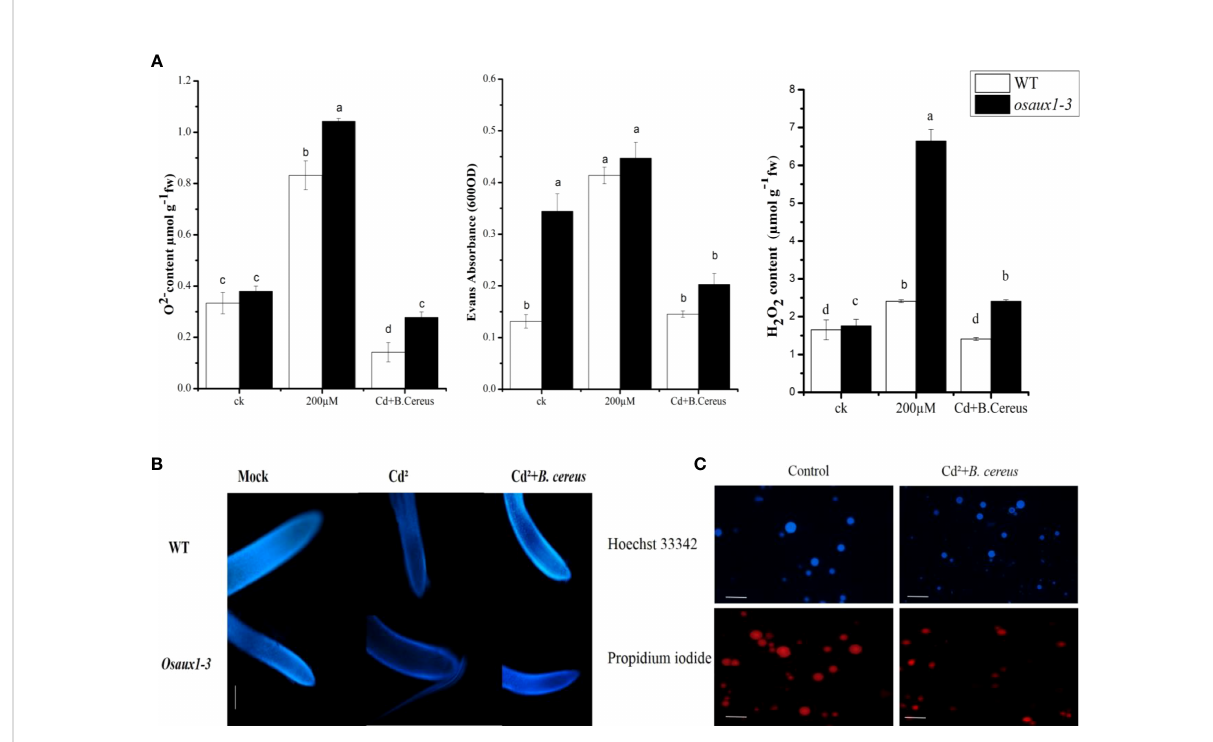
FIGURE 4 (A) Effect of Cd augmentation on H 2 O 2 , O 2 , and cell death in rice. Accumulation of O − 2 and H 2 O 2 was measured in wild-type and osaux1-3 mutant exposed to 200 µM of CdCl 2 for 7 days. Cell death was also assessed after days of wild-type and osaux1-3 by Evans Blue staining exposed to 200 µM of CdCl 2 for 7 days. (B) Histochemical detection of (B) cereus -inoculated and noninoculated wild-type and osaux1-3 root tips exposed to 200 µM of CdCl 2 with Hoechst 33342 staining image was visualized after 7 days of stress using Nikon Eclipse DS Ri2 microscope. Scale bars = 2µm. (C) Cultural staining of (B) cereus with Hoechst 33342 and propidium iodide in the presence of Cd. The bacterial culture was grown in an LB medium with 10 8 CFU. Lowercase letters indicate signi fi cant differences between means, determined using Duncan ’ s multiple range mean